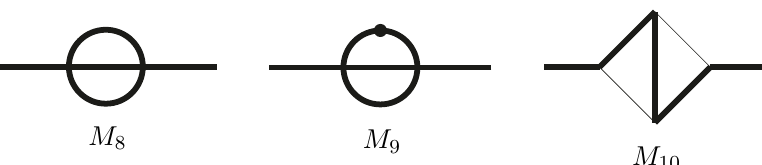
Figure 3 . Master integrals of family B contributing to diagram (a). Bold solid lines represent massive propagators, thin solid lines represent massless propagators. A dot on a line means that the associated propagator is squared. The solutions for these o(cid:11)shell sunrise and kite type integrals can be found in the literature. We give the results for their imaginary parts and small s expansion necessary for our calculation in appendix